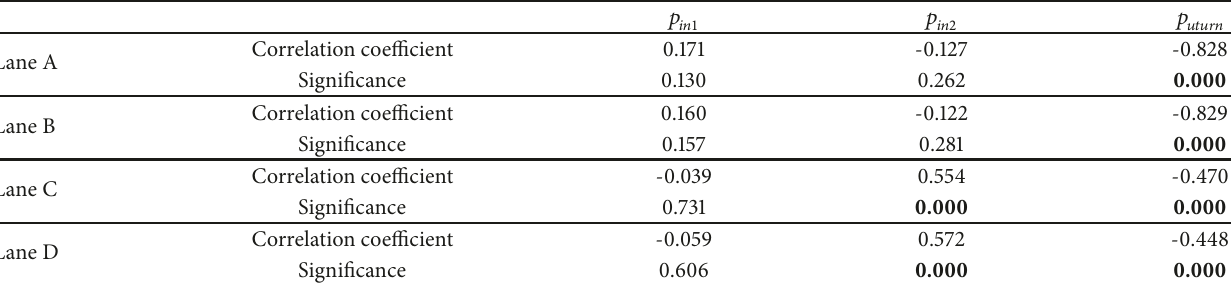
Figure 9: Impact of factors on volume in lane. (a) Lane A. (b) Lane C. Table 5: Correlation matrix of influencing factors for